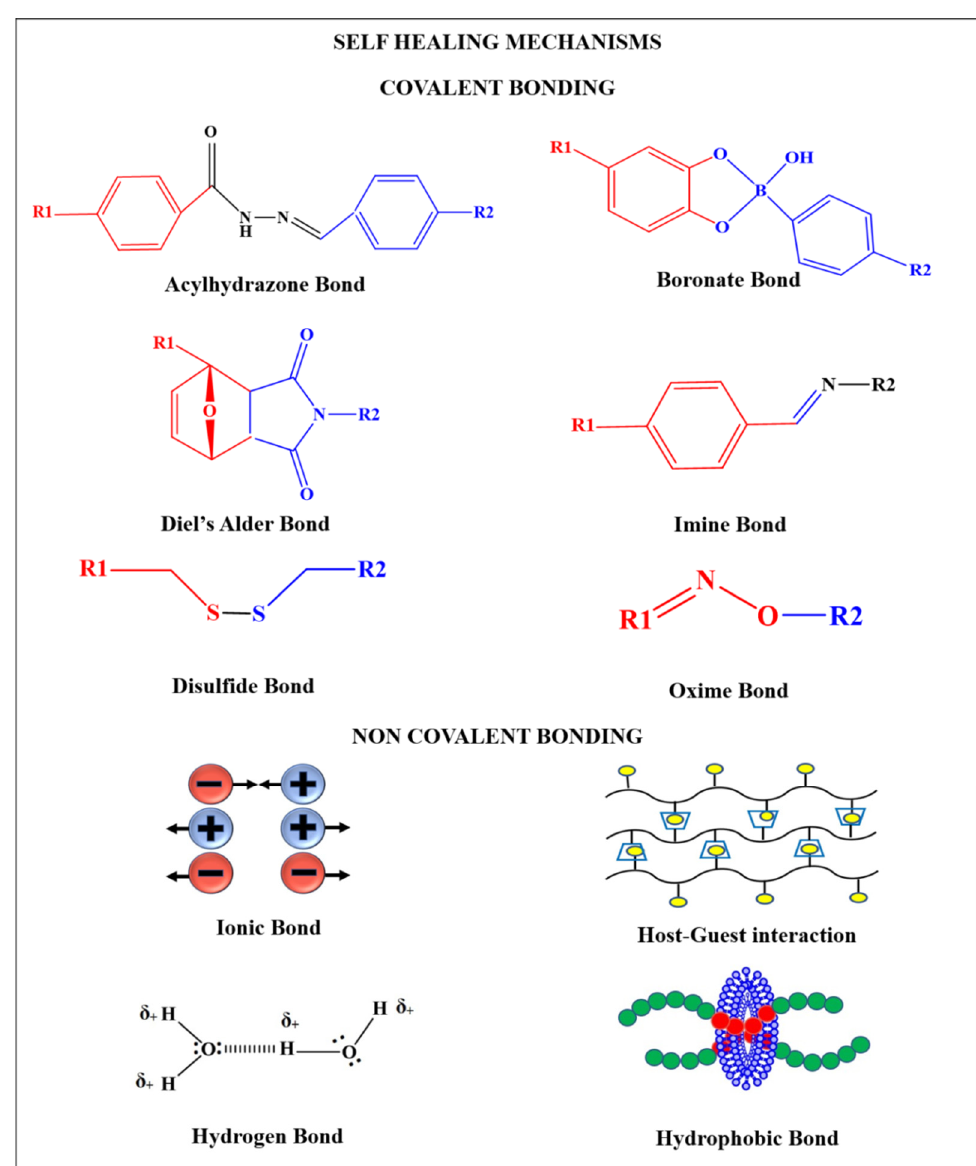
Figure 2. Bonds involved in self-healing mechanisms.